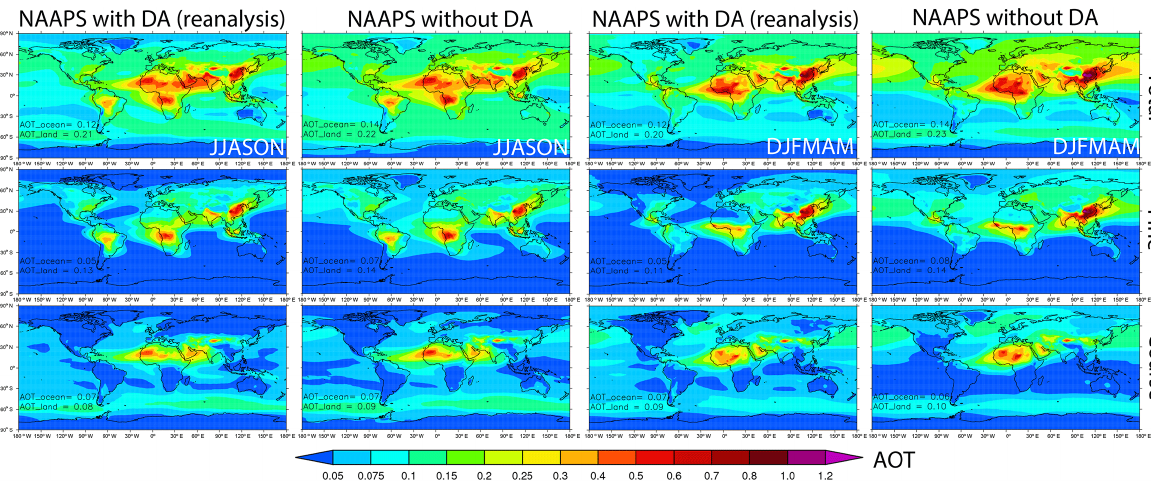
Figure 5. 2003–2013 averaged bi-seasonal (June–November, i.e., JJASON, and December–May, i.e., DJFMAM) total (upper), fine (middle) and coarse (bottom) AOTs at 550nm from NAAPS with and without AOT data assimilation. Annotations at the bottom left in the figures show the area mean AOTs over ocean and over land averaged for 40 ◦ S–60 ◦